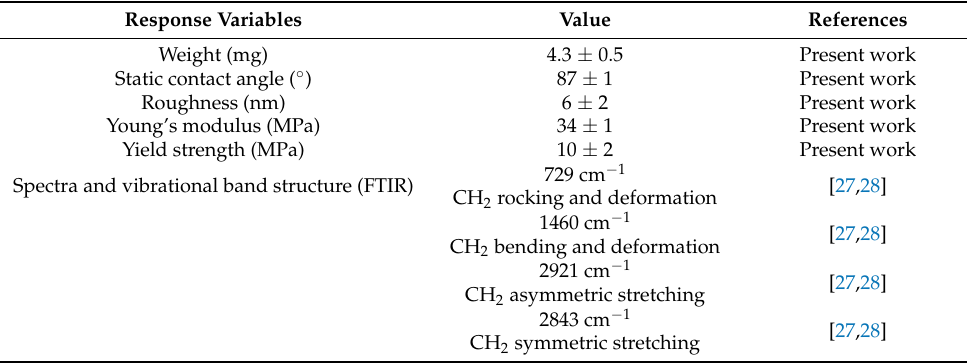
Table 1. Pristine low-density polyethylene (LDPE) sheet initial